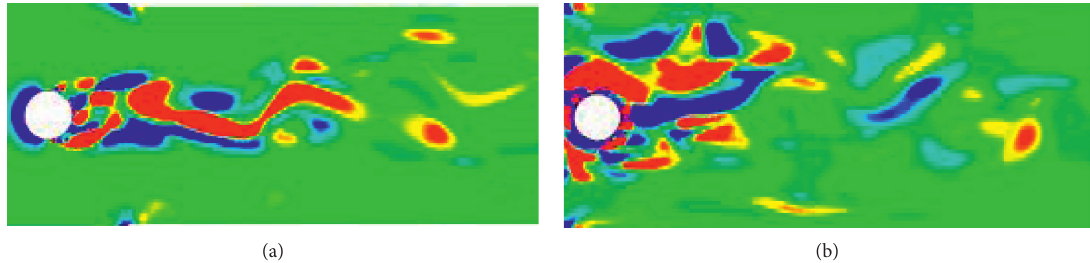
Figure 20: Vorticity contours. (a) Vorticity contour of single casing. (b) Vorticity contour of thermocouple with interference device. vortex wake. Figure 20(b) indicates that boundary layer